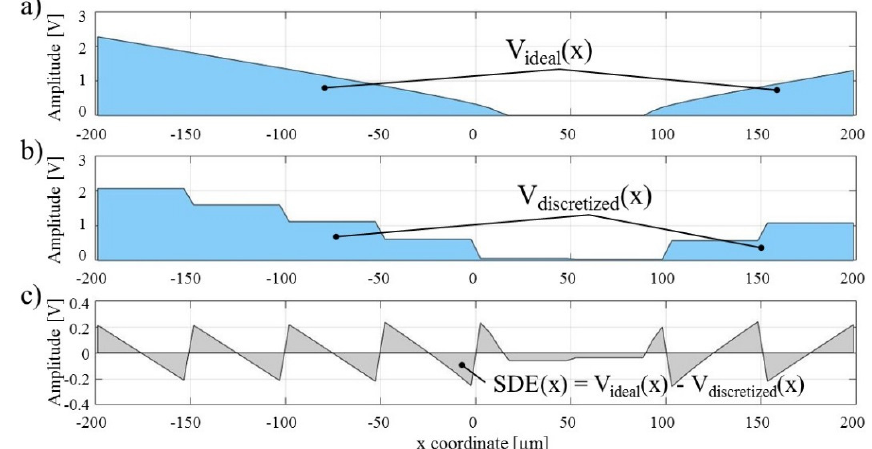
Figure 2. Example electric potential distributions ( a ) Ideal case; ( b ) Discretized case; ( c ) Space discretization error (SDE).